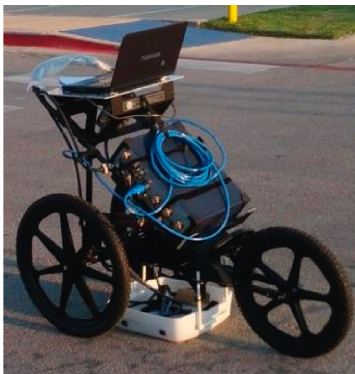
Figure 7: Cart-mounted GPR with the antenna and data acqui- sition system.